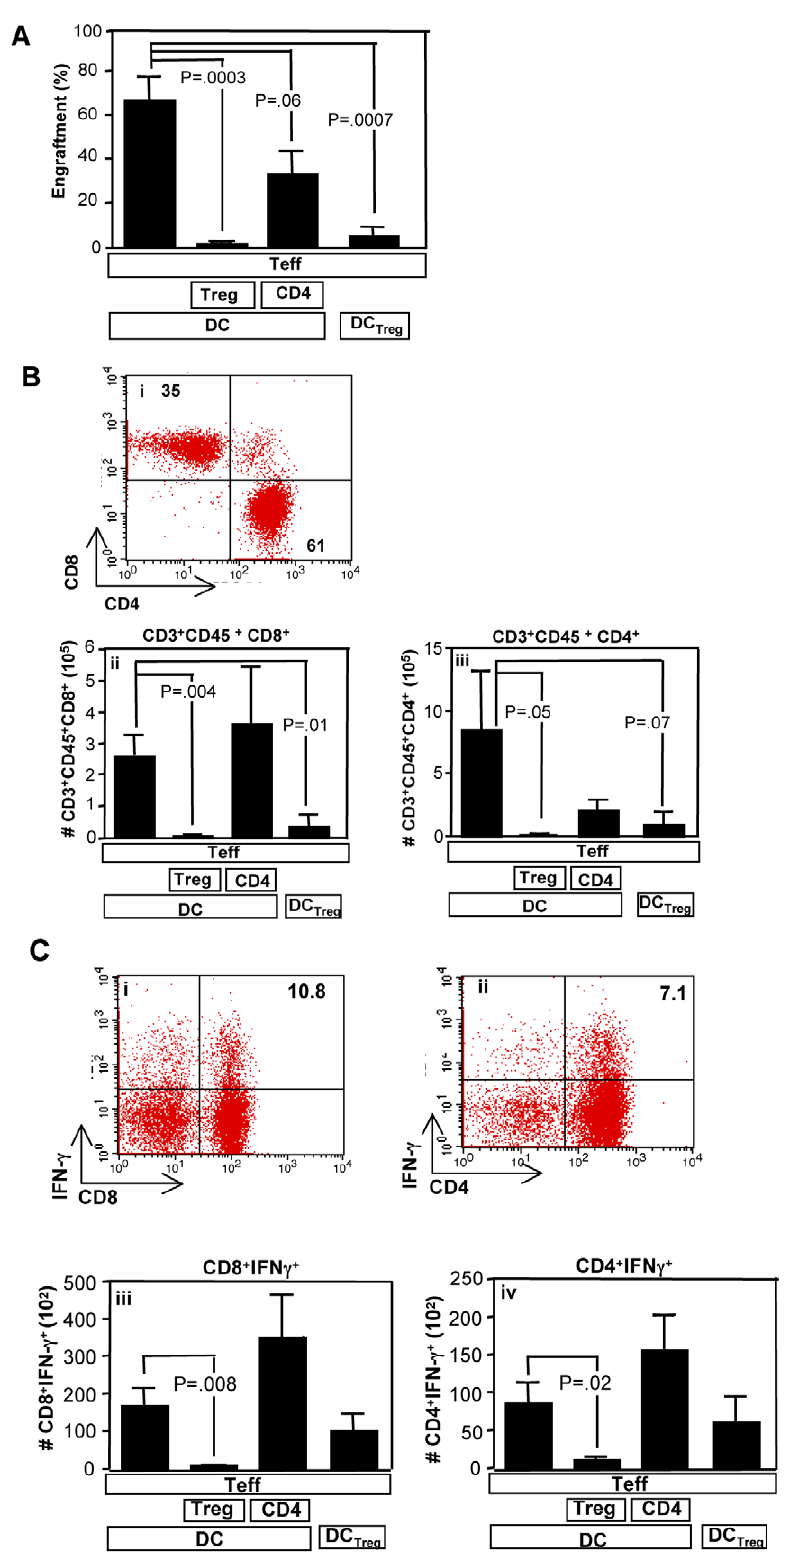
Figure 4. Reduction in human effector T cell numbers in vivo by Tregs or Treg-conditioned DC. Rag2 2 / 2 c c 2 / 2 mice were reconstituted with human cells, as indicated, including: effector Th1/Tc1 cells (‘‘Teff’’); untreated DC (‘‘DC’’) or Treg-conditioned DC (‘‘DC Treg ’’); and ex vivo– generated control CD4 cells (‘‘CD4’’) or regulatory T cells (‘‘Treg’’). Teff, DC, and Treg doses were 1 6 10 7 , 0.5 6 10 6 , and 0.5 6 10 6 cells per recipient, respectively. One additional cohort received Teff cells in combination with control CD4-conditioned DC; this cohort is not shown because of early posttransplant lethality due to xenogeneic GVHD. (A) Spleens were harvested on day 45 posttransplant and percent human cell engraftment was